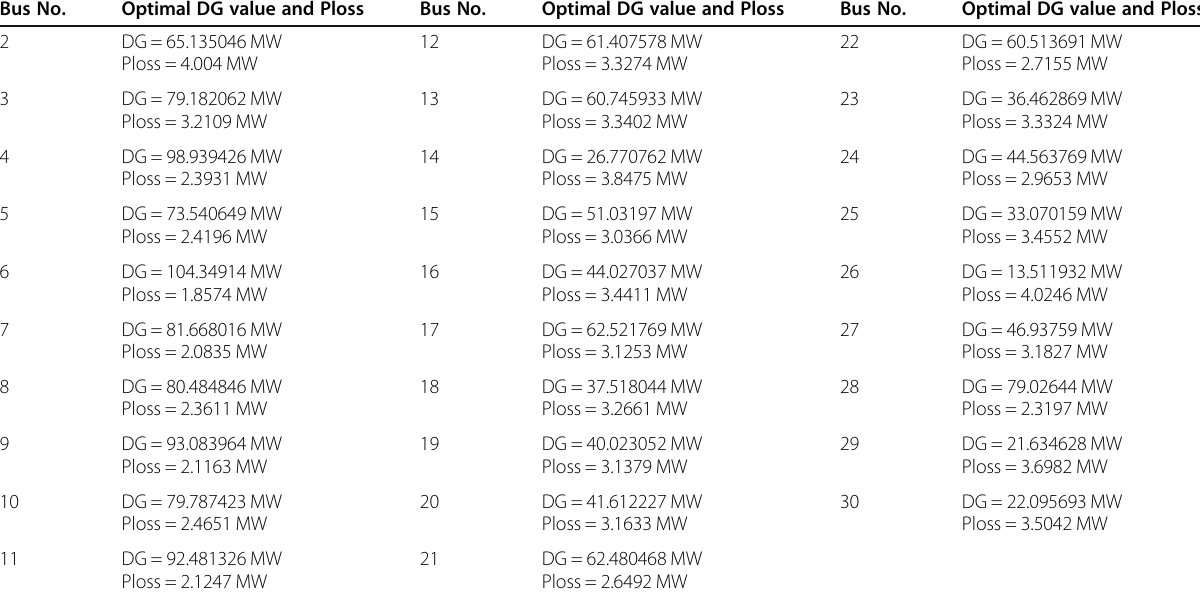
Table 14 Optimum solution for the IEEE 30 bus system with DG individually injected at each bus using the JAYA algorithm Bus No. Optimal DG value and Ploss Bus No. Bus No.